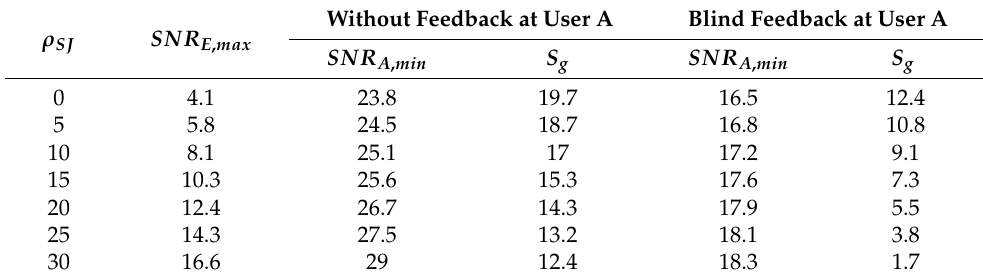
Table 3. Security gap S g in case of passive eavesdropper.